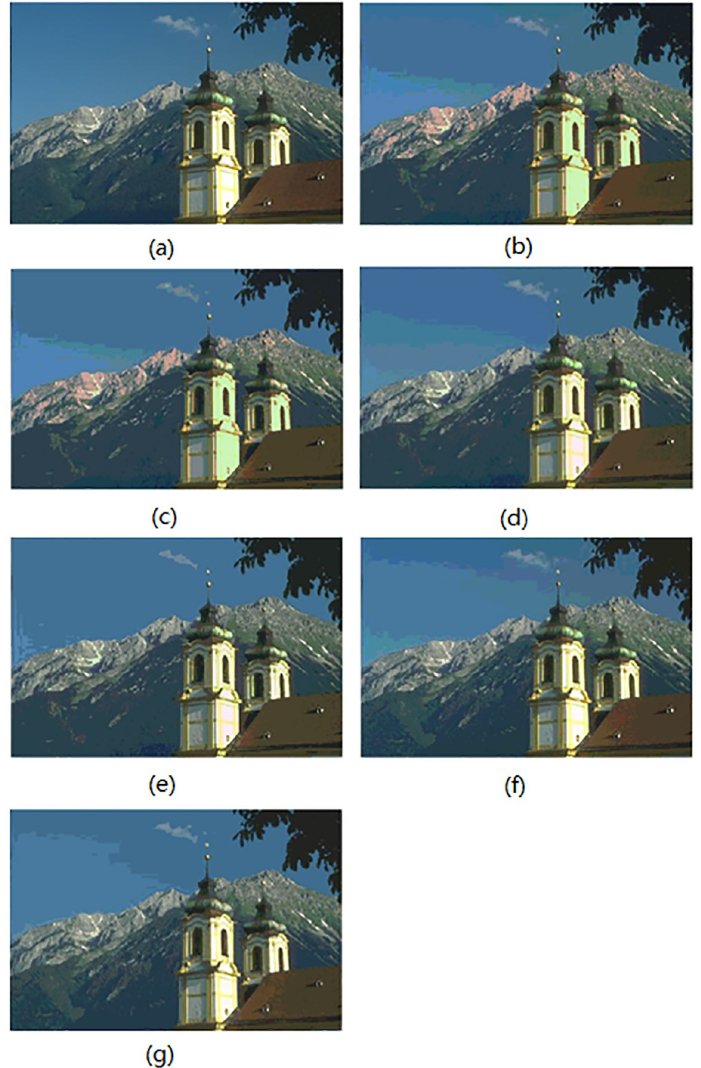
Fig 5. The image Church : (a) original image, (b, c) initial segmented result and result after region merging based on the histon, (d, e) initial segmented result and result after region merging based on the roughness index, (f, g) initial segmented result and result after region merging based on AHHT